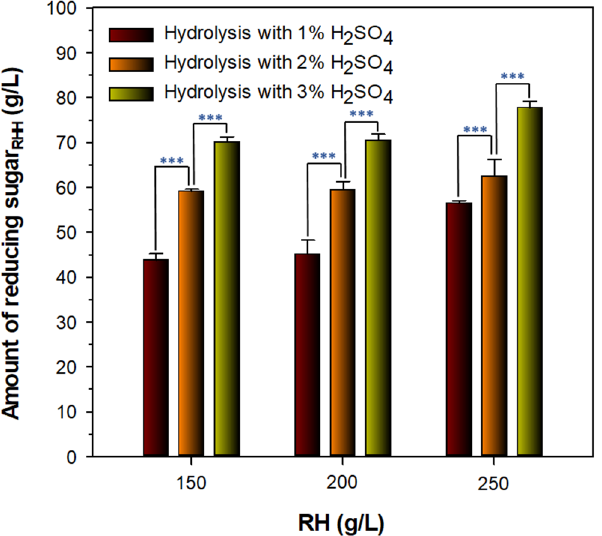
Figure 2. Thermochemical hydrolysis of different RH samples treated with H 2 SO 4 at concentrations of 1, 2, and 3%, respectively. The values are mean ± SD of triplicate tests. p ‐ values were calculated using two ‐ tailed Student’s t ‐ test: *** p < 0.001.